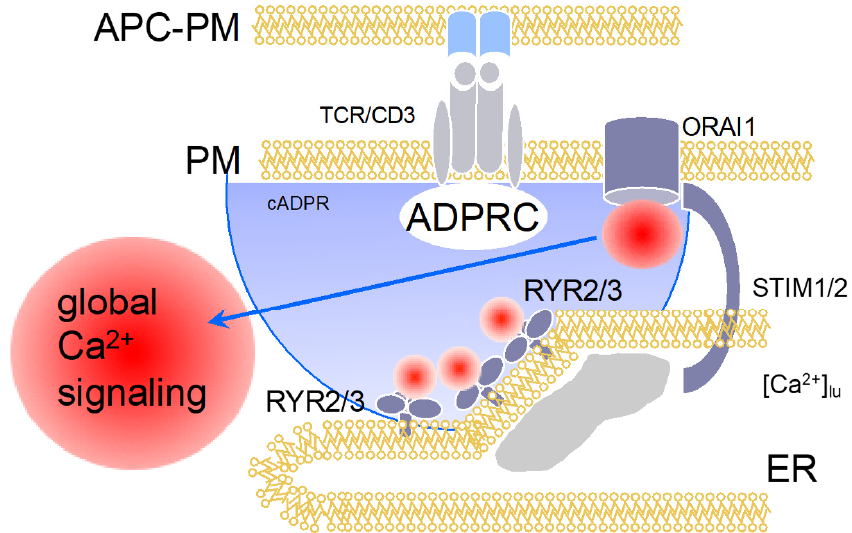
Figure 3. Ca 2 + signaling in a later phase ( > 15 min) of T cell activation: cADPR-dependent global Ca 2 +